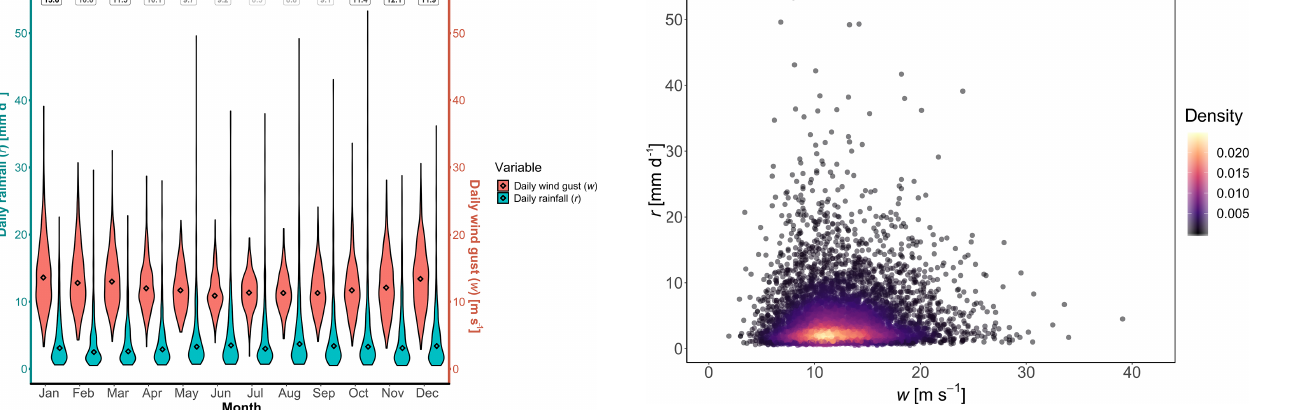
Figure 8. Violin plots of daily wind gust w (red) and daily non- zero rainfall r (blue) by month for the period 1 January 1971 to 31 May 2018 at the Heathrow Airport weather station, UK. Dia- monds represent the median of all values for that month from 1971– 2018. Numbers at the top of the graph represent the average number of days per month where there is recorded both non-zero rainfall r> 0mmd − 1 and wind gusts w> 0ms − 1 . Daily rainfall data from E-OBS (Cornes et al., 2018) and wind gust data (maximum 3s wind velocity in a day) from the Met Office (2019).